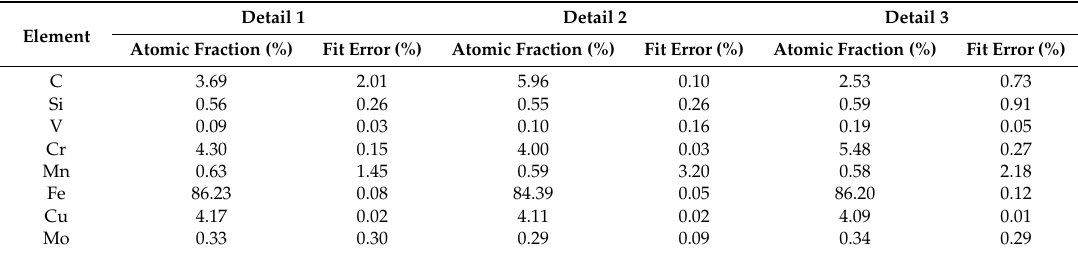
Table 5. Analysis of the chemical composition in each detail according to Figure 9. Detail 1 Detail 2 Detail 3 Element Atomic Fraction (%) Fit Error (%) Atomic Fraction (%) Fit Error